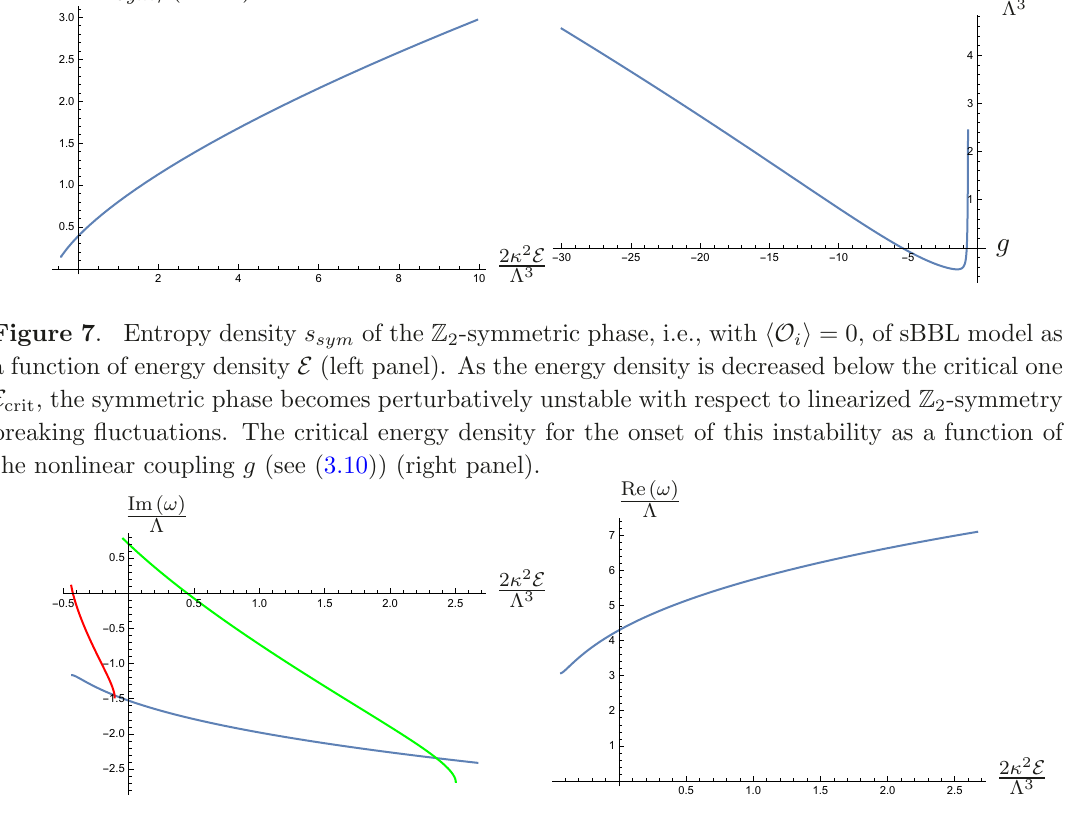
Figure 8 . Left panel: spectrum of Z 2 symmetry breaking QNM in sBBL model at g = curve) and g = 8 (green curve) at vanishing spatial momentum. These QNMs have vanishing real − part. The blue curves (both panels) represent the spectrum of QNM in sBBL model that connect to standard ∆ = 1 QNM of AdS 4 black brane in the limit